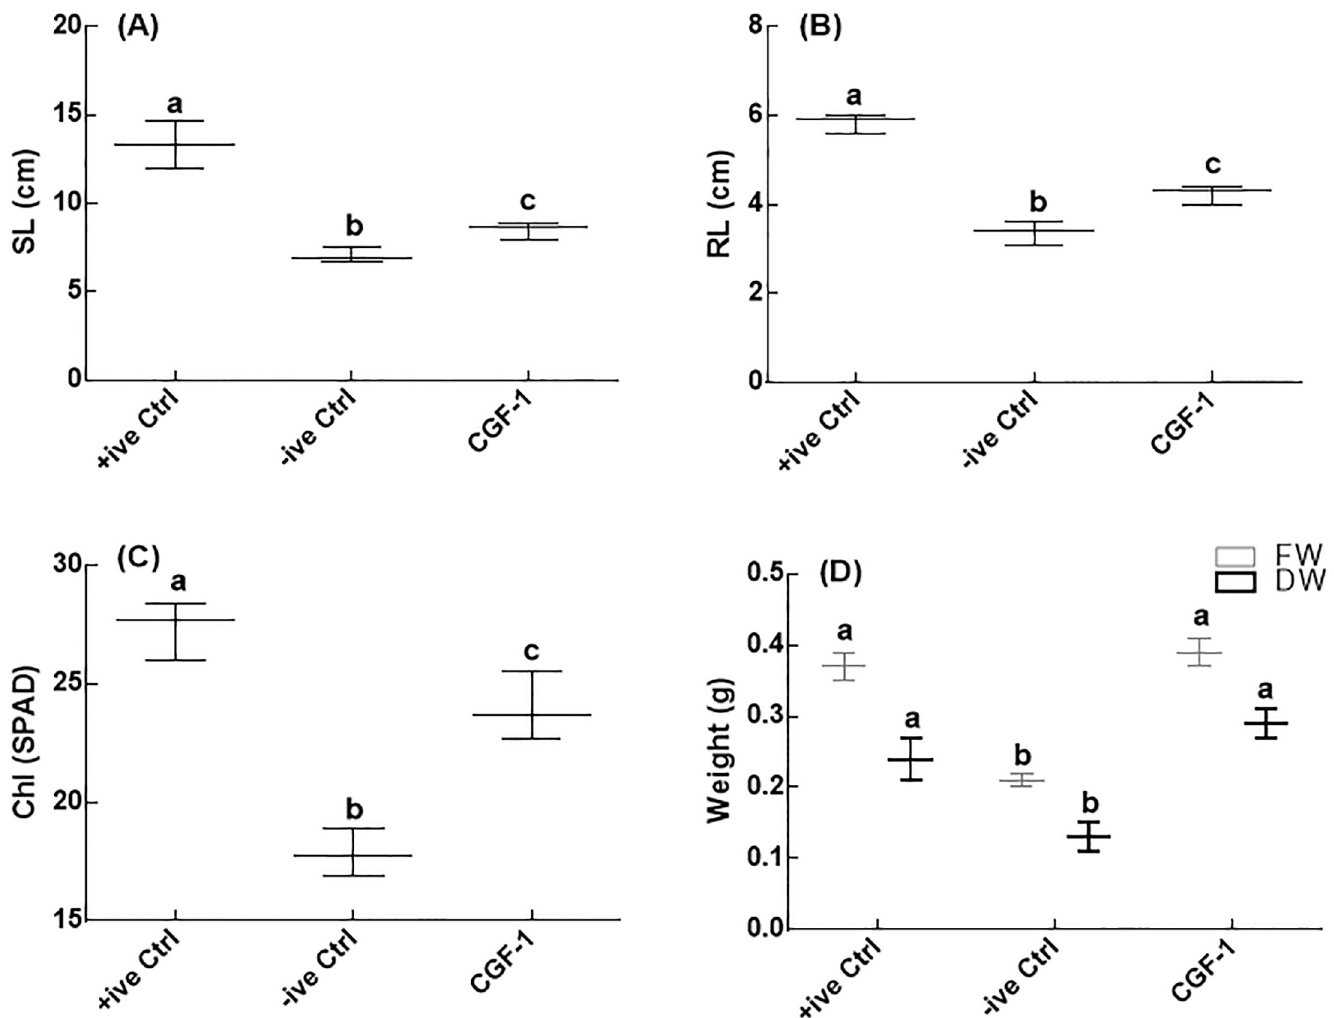
Fig 1. Plant growth promoting activity of isolated fungal strain CGF-1 from halophytic plant S . surattense Burm.f. +ive control = IAA mutant kernal ( dek 18 ) maize line treated with distil water; -ive control = wild kernal ( Dek 18 ) maize line grown under metal stress; CGF1 was applied to wild kernal ( Dek 18 ) maize line grown under metal stress. Fig 1A represents shoot length; Fig 1B represents root length; Fig 1C represents chlorophyll content; Fig 1D represents weight of the plants; SL = shoot length; RL = root length; Chl = chlorophyll. The experiment was carried out in triplicate, each replicate comprised of 10 pots and each pot contained 6 seedlings (total = 6 × 10 × 3 = 180 seedlings per treatment). The boxplots having different letters are significantly different from each other at P < 0.05.